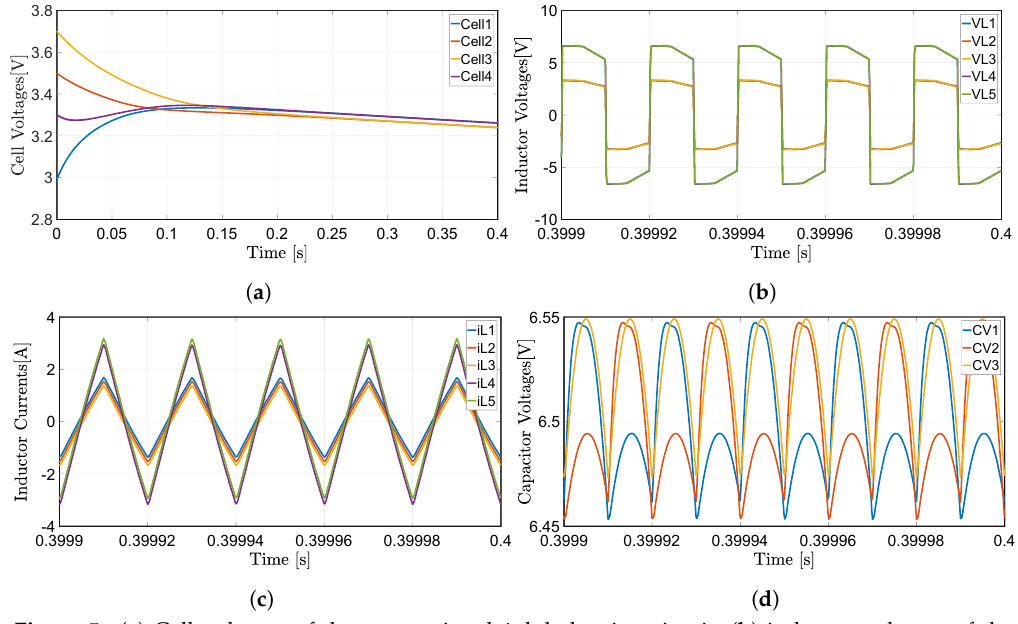
Figure 5. ( a ) Cell voltages of the conventional ´cuk balancing circuit; ( b ) inductor voltages of the conventional ´cuk balancing circuit in steady-state; ( c ) inductor currents of the conventional ´cuk balancing circuit in steady-state; and ( d ) capacitor voltages of the conventional ´cuk balancing circuit in